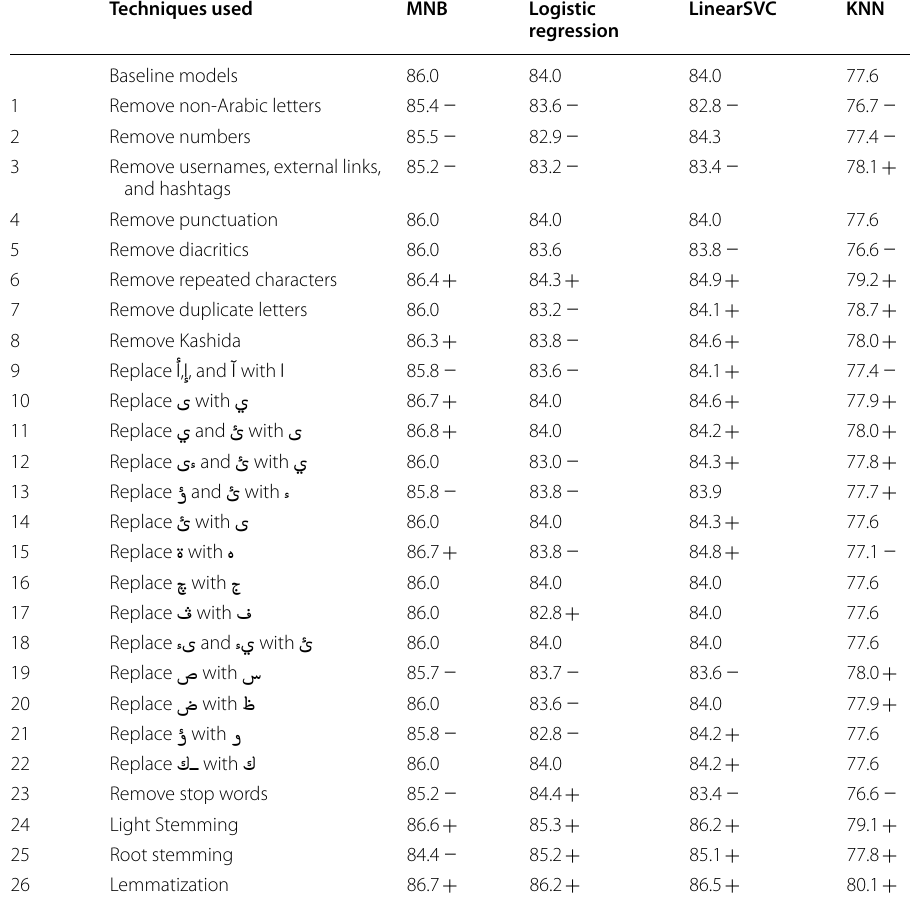
Table 5 Accuracy (in percentages) of each of the pre-processing techniques used for the extracted